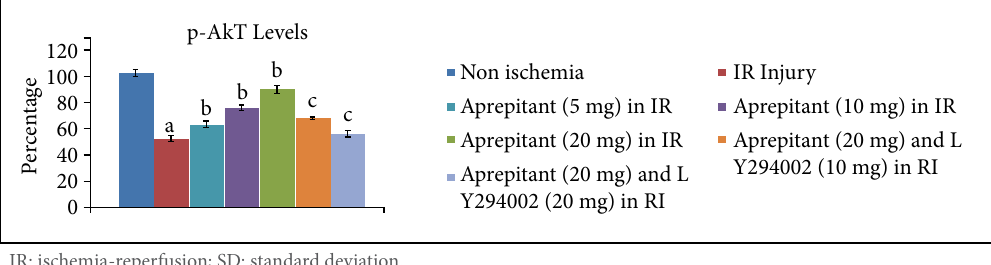
Figure 4 - Effect of aprepitant and LY294002 on ischemia-reperfusion induced changes in p-Akt levels in the heart homogenate. Values are given as mean ± SD. (a) p < 0.05 vs . non-ischemia;